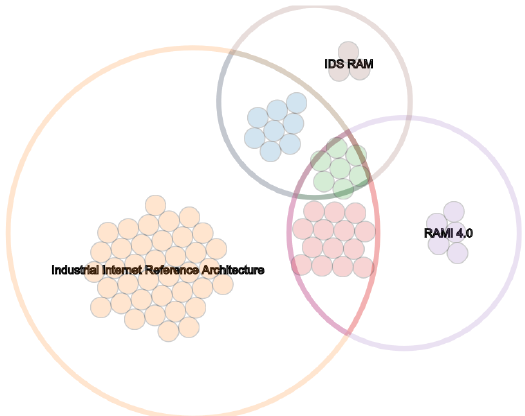
Figure 6. Comparison of RAMI4.0, IDS-RAM and IIRA by considered